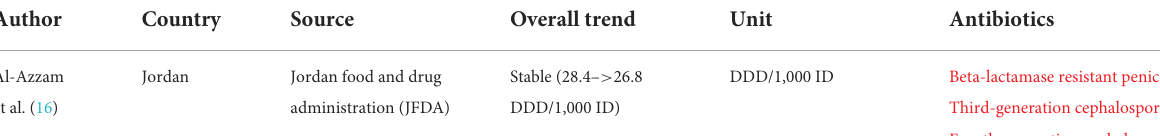
TABLE 3 Antibiotic consumption trend at regional or national levels showing the overall trend and individually reported